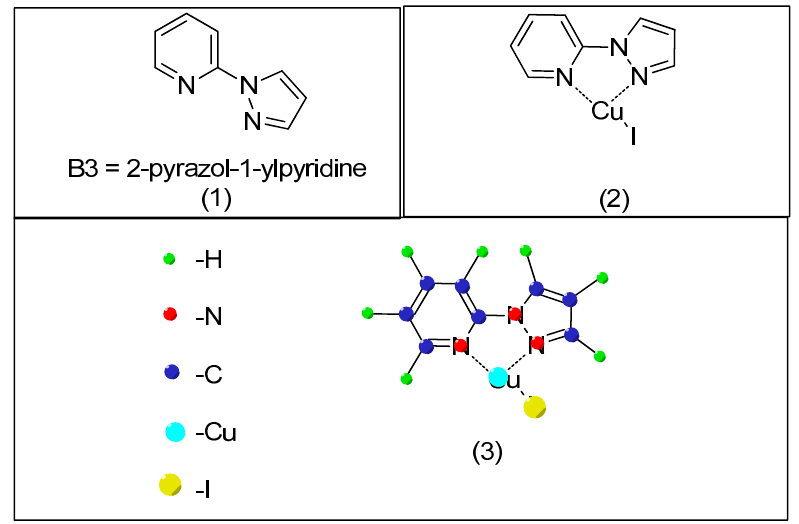
Figure 12. ( 1 ) 2-pyrazol-1-ylpyridine ligand (B3); ( 2 ) 2-pyrazol-1-ylpyridine ligand with CuI; ( 3 ) structures of monomeric complexes of a 2-pyrazol-1-ylpyridine ligand with CuI. In this study, a non-radical mechanism was proposed in the Ullmann-type C-O bond formation reaction. Initially, pyrazole ligand makes a coordination complex with copper ion. When the reaction is started, oxidative addition (OA) will first occur, in which the Cu + undergoes OA with aryl halide to form Cu 3+ intermediate A. Then, the phenoxide undergoes nucleophilic substitution (NS) and through the reductive elimination (RE) biaryl ether is generated and the Cu 3+ reduced o Cu + . The proposed ligand B3, which has N py and N pz , play a different role in the reaction, where N py is more likely the electron-rich copper center and encourages the coordination of aryl halide. N pz play the role to lower and speed up the NS and RE step. This mechanism corresponds to the steric effect of the substituent at ortho-position in aryl halide rather than phenol due to an aromatic group of the former binding straight to the copper atom in the intermediate A (Scheme 42b), and Cu-O